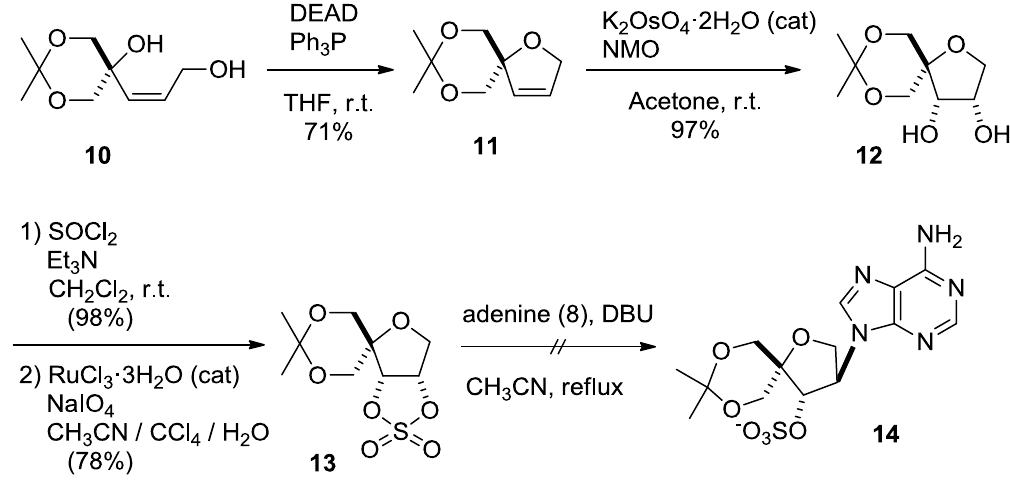
Scheme 2. Second attempt to introduce adenine using a cyclic